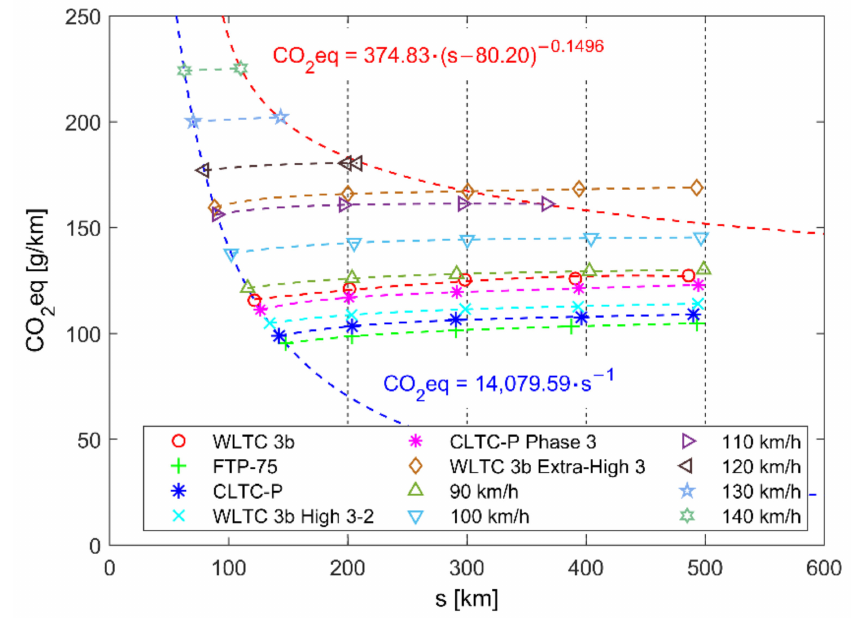
Figure 13. Combined CO 2 eq emission, due to EREV operation and electricity production (Poland), in various driving conditions. Note that the blue approximation line (BEV mode) and the red approximation line (maximal range) are obtained for constant speed driving results from the range of 90–140